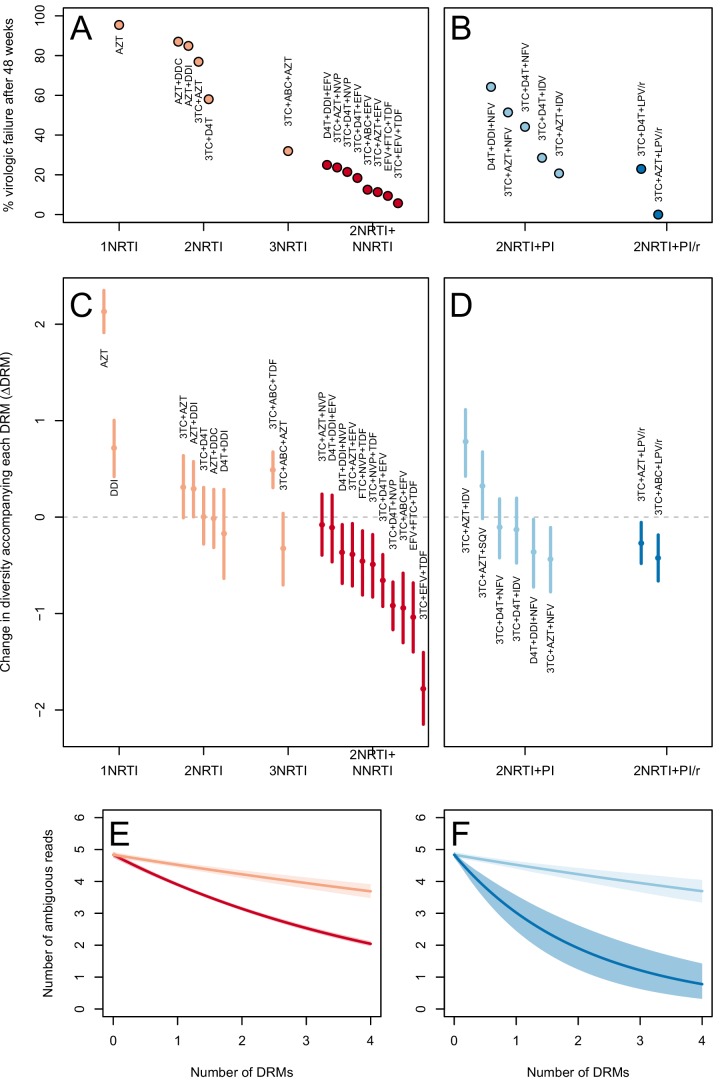
Drug resistance mutations are correlated with diversity reduction differently in different types of treatments.Treatment effectiveness from literature review (percentage of patients with virologic suppression after ~48 weeks) showed positive correspondence with clinical recommendation among RTI regimens (A) and PI+RTI regimens (B). Diversity reduction accompanying a DRM (ΔD⁢R⁢M from the GLMM) lower among the more effective and clinically recommended treatments among RTI treatments (C) and RTI+PI treatments (D). 95% confidence intervals are plotted by excluding the highest 2.5% and lowest 2.5% of GLMM random effect fits of the 1000 subsampled datasets and treatments are ordered by mean ΔD⁢R⁢M within treatment categories. Generalized linear model fits show significantly different slopes for NNRTI treatments versus NRTI treatments (E) and PI/r treatments versus PI treatments (F). Confidence intervals are plotted by excluding the highest 2.5% and lowest 2.5% of GLM fits to 1000 subsampled datasets.